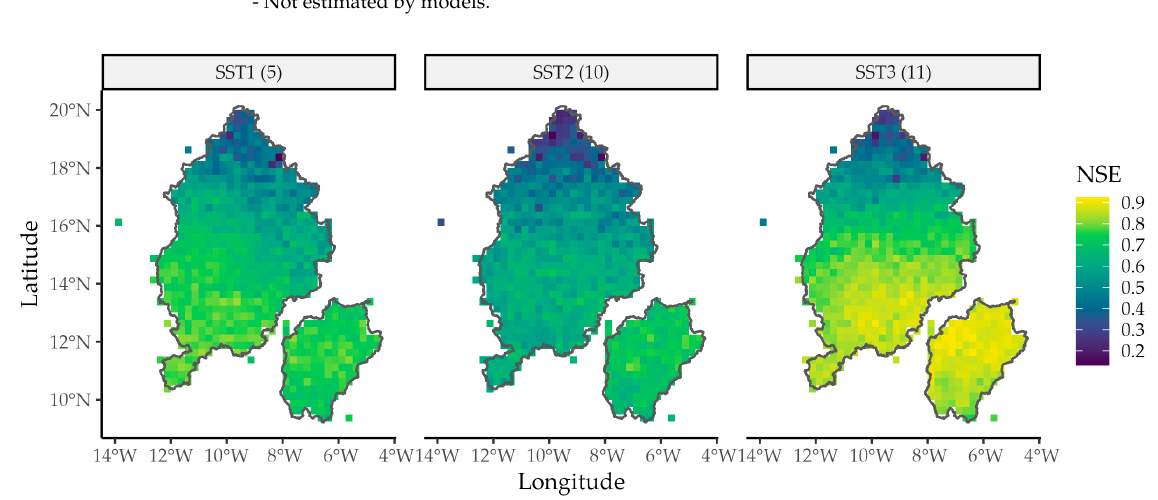
Figure 4. Spatial distribution of NSE with the polynomial model in the 3 SST regions of the Atlantic and their respective time lags (5 months for SST1, 10 months for SST2, and 11 months for SST3). Rainfall forecasts with the polynomial model (Figure 4) adequately reproduce sea- sonal rainfall of the WAM. Figure 5 shows the spatio-temporal distribution of the rainfall forecast. It shows that it is temporarily distributed between May and October, mainly in the south of the Bani and Senegal basins. In July and August, the rainfall is distributed throughout the basins’ area, with a decrease in rainfall as latitude increases. Rainfall fore- casts from 1984 to 2020 are presented in Table A1, Appendix A (as complementary mate- rial). The average rainfall in the period 1984–2020 is ~690 mm yr − 1 , the minimum is ~490 mm in 1985, and the maximum is ~830 mm in 2016.